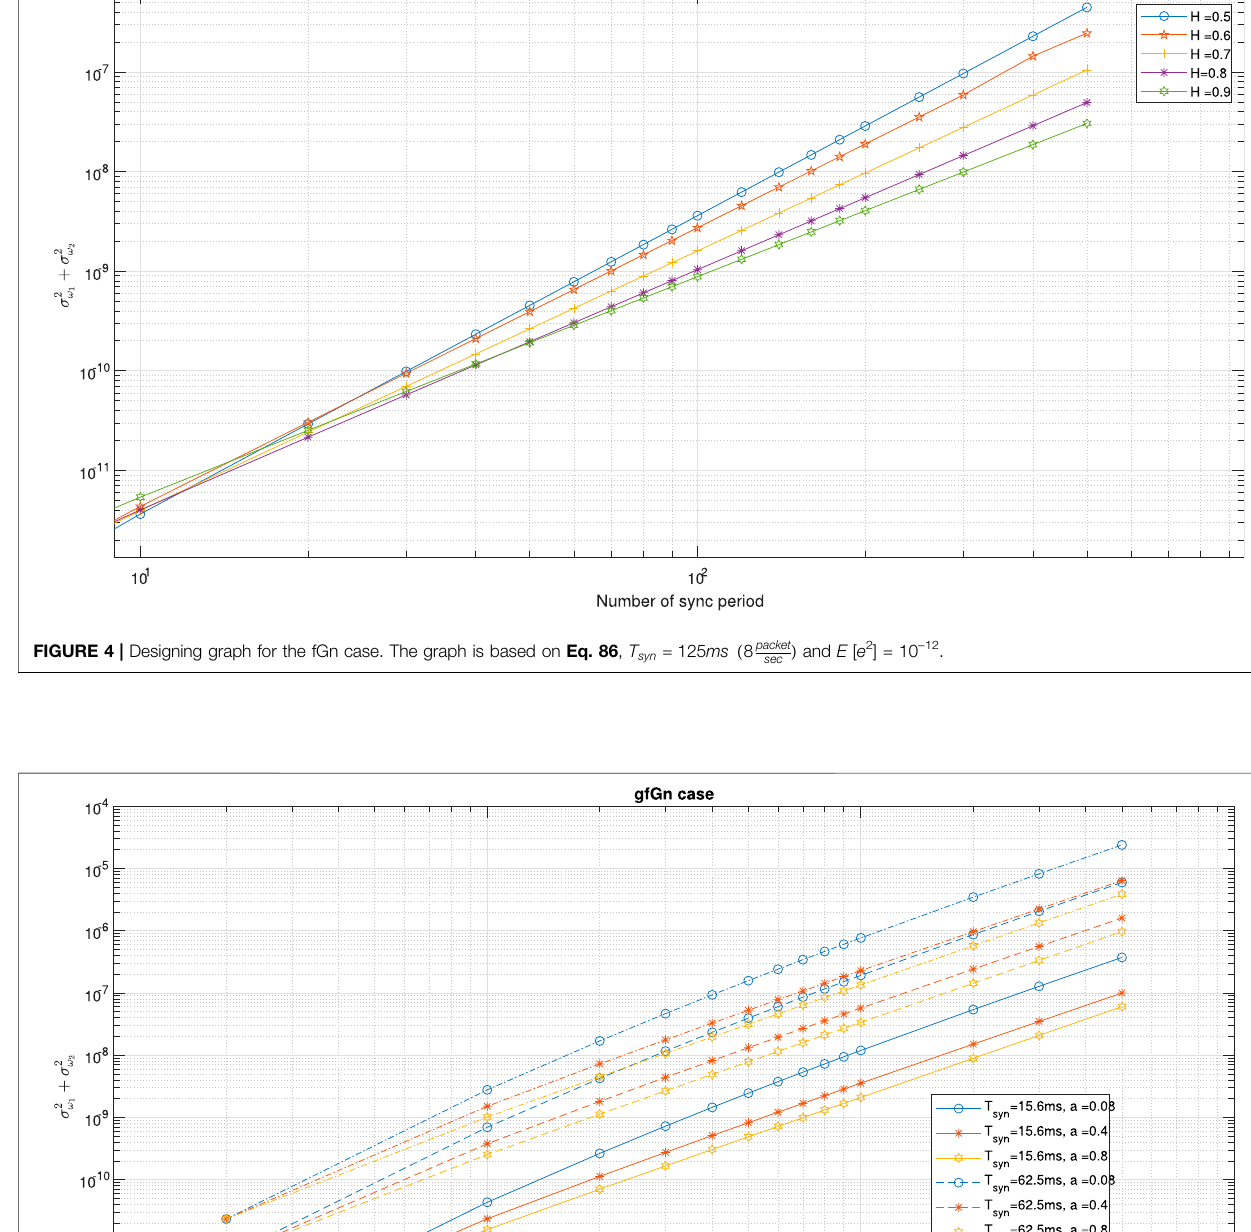
FIGURE 5 | Designing graph for the gfGn case. The graph is based on Eq. 86 , E [ e 2 ] (cid:1) 10 – 12 and H (cid:1) 0.95.